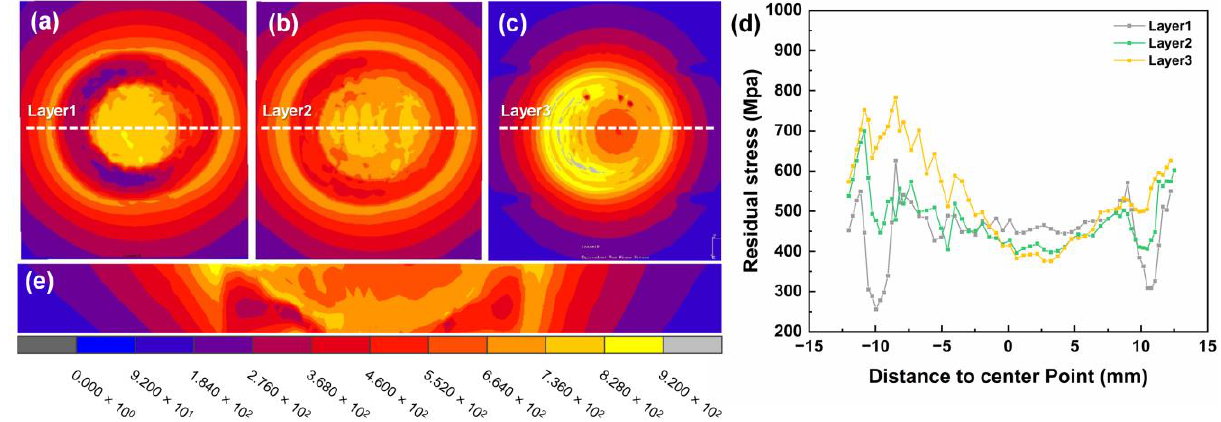
Figure 11. Von Mises stress distribution along different layers with focused diameter of 2.5 mm: ( a ) First layer, ( b ) Second layer, ( c ) Third layer, ( d ) Von Mises stress values, ( e ) Along vertical direction.